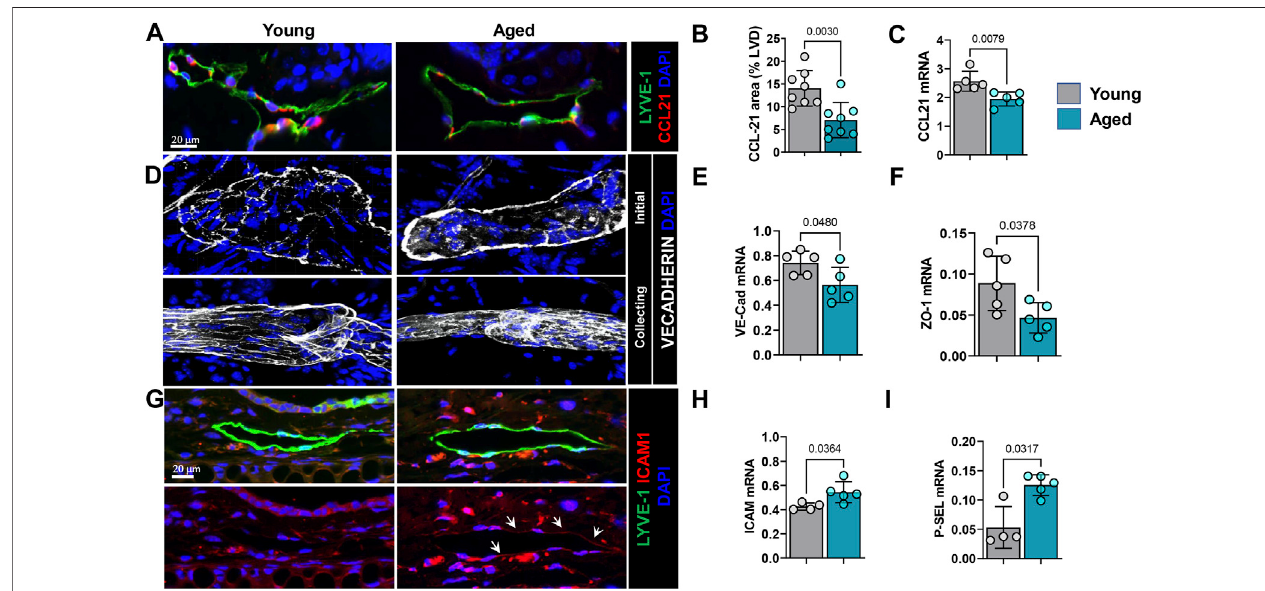
FIGURE 6 | Aging causes decreased chemokine and altered junctional protein expression by LECs. (A) Representative confocal images of ear skin sections stainedforlymphaticvessels(LYVE-1)andCCL21. (B) Quanti fi cationofCCL21immunostainingasapercentageoflymphaticvesselarea. (C) qRT-PCRquanti fi cationof CCL21 mRNA expression in sorted skin LECs. (D) Representative confocal images of ear skin wholemount stained for nuclei (DAPI), VE-cadherin (upper panel, Initial lymphatics; lower, collecting lymphatics). (E) qRT-PCR quanti fi cation of VE-cadherin and (F) ZO-1 mRNA expression in sorted skin LECs. (G) Representative confocal images of ear skin sections stained for lymphatic vessels (LYVE-1) and ICAM-1 (upper panel, immuno fl uorescence of both; lower, ICAM-1 only). (H) qRT-PCR quanti fi cation of mRNA expression of endothelial adhesion molecules ICAM-1 and (I) p-Selectin from sorted skin LECs. n = 5 mice from each group. All quanti fi cations are mean ± SD, unpaired Student ’ s t